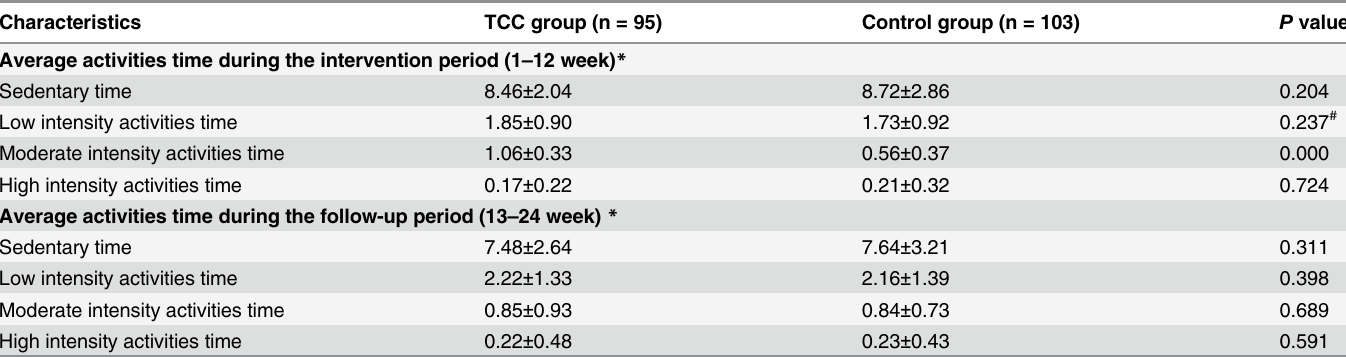
Table 2. Comparison of average activities time during the 12-week intervention and 12-week follow-up period between groups (hours).